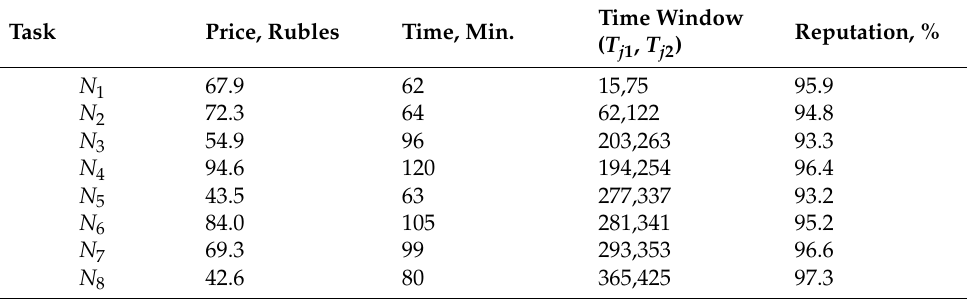
Table 3. DP transport task set demand parameters. Task